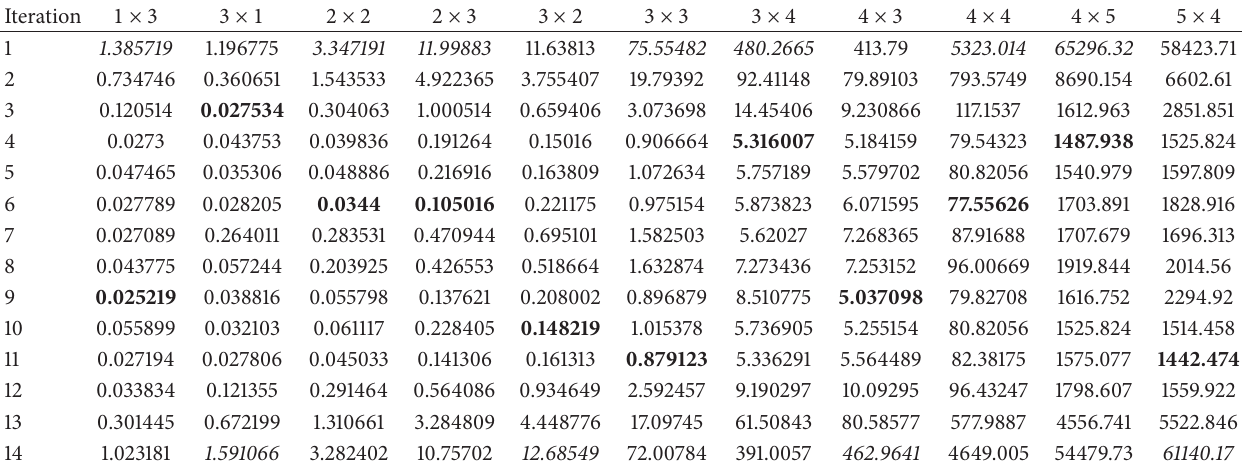
Table 1: The evaluation results of Figure 3 with different neighborhood selections.